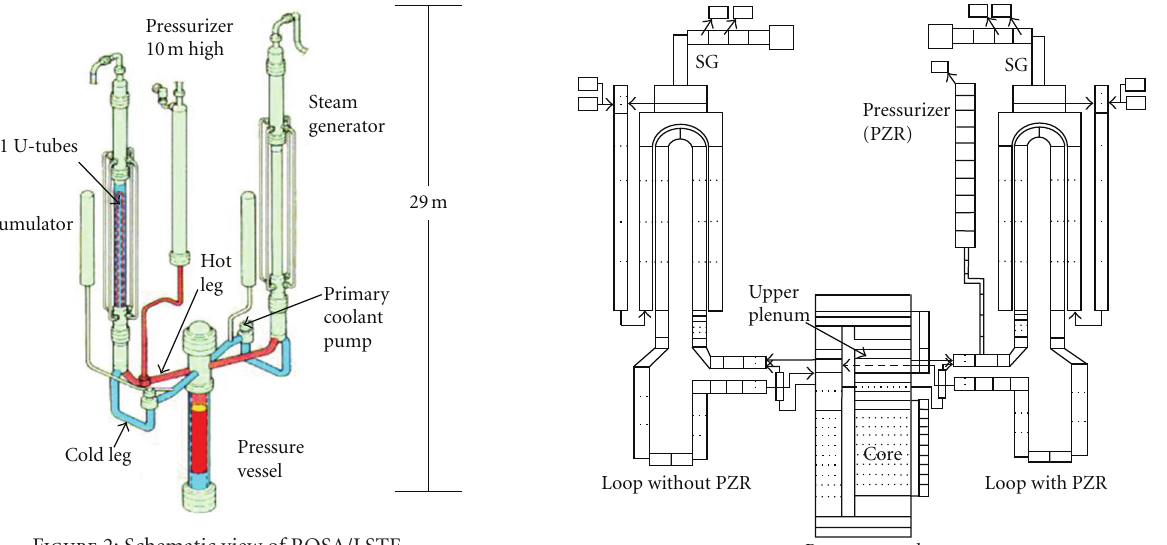
Figure 2: Schematic view of ROSA/LSTF. Table 1: Details of LSTF U-tubes in each SG.